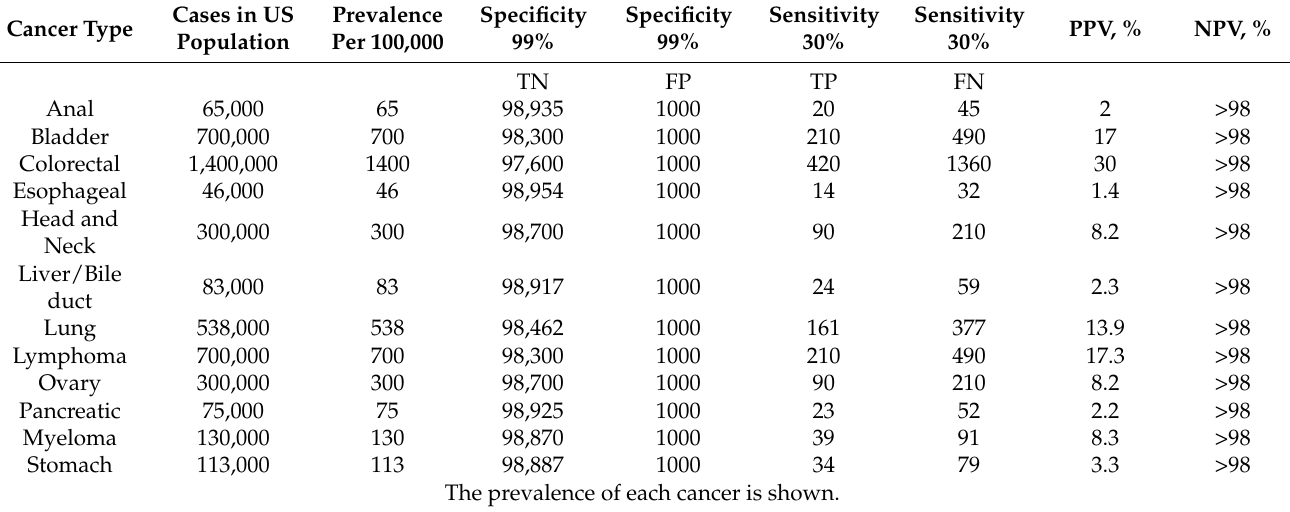
Table 1. Positive and negative predictive value of a test with 30% sensitivity and 99% specificity for var ious cancers 1